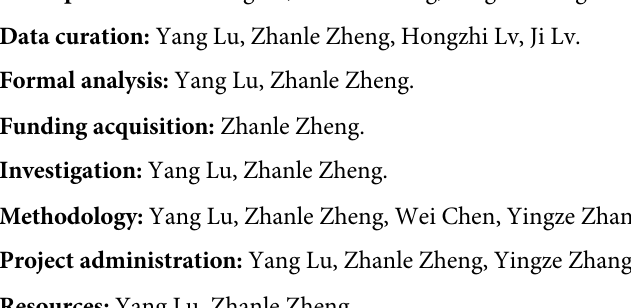
S1 Table. The original data of our research about measuring (female). S2 Table. The original data of our research about measuring